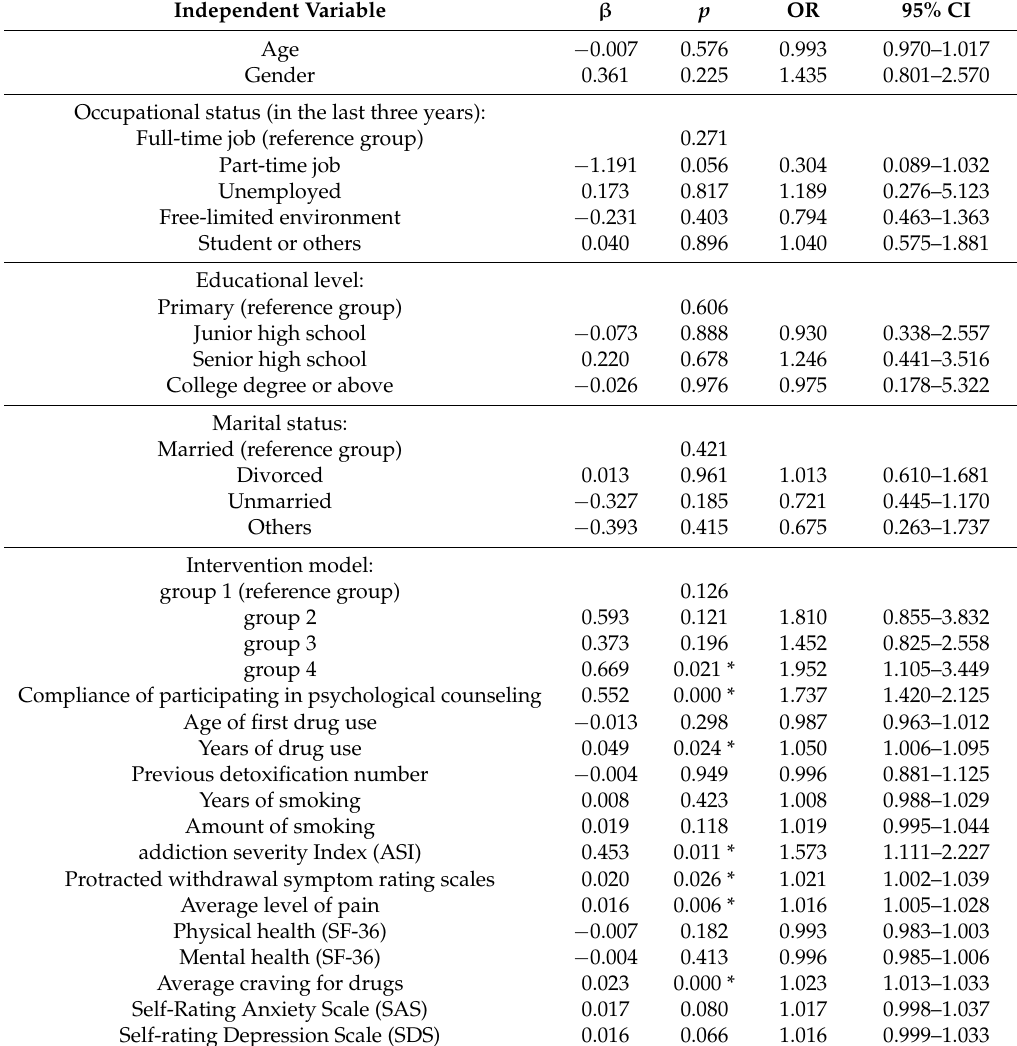
Table 4. The result of the univariate Cox regression